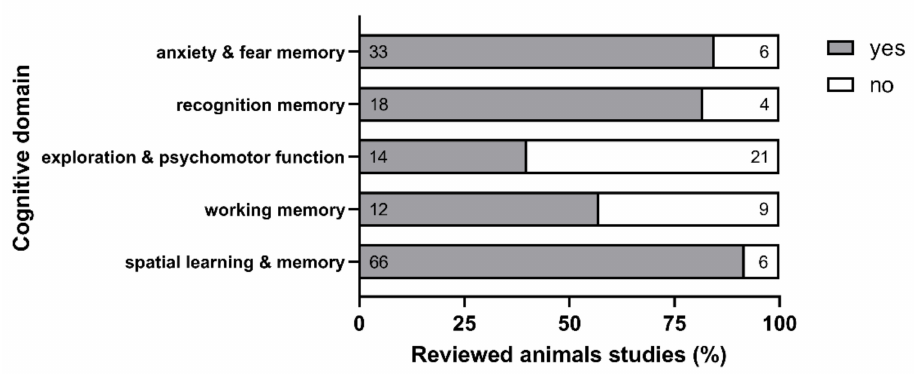
Figure 7. Impact of HHCys on cognitive performance; data resulting from the analysis of the reviewed animal studies (numbers in the bars indicate the absolute amount of underlying studies); different cognitive domains were analyzed: anxiety and fear memory (39 studies), recognition memory (22), exploration and psychomotor function (35), working memory (21), spatial learning and memory (72); in total, cognitive tests were performed in 102 of the reviewed animal studies; further methodological details are provided in the appendix of this review; created with GraphPad Prism 8 (San Diego, CA,